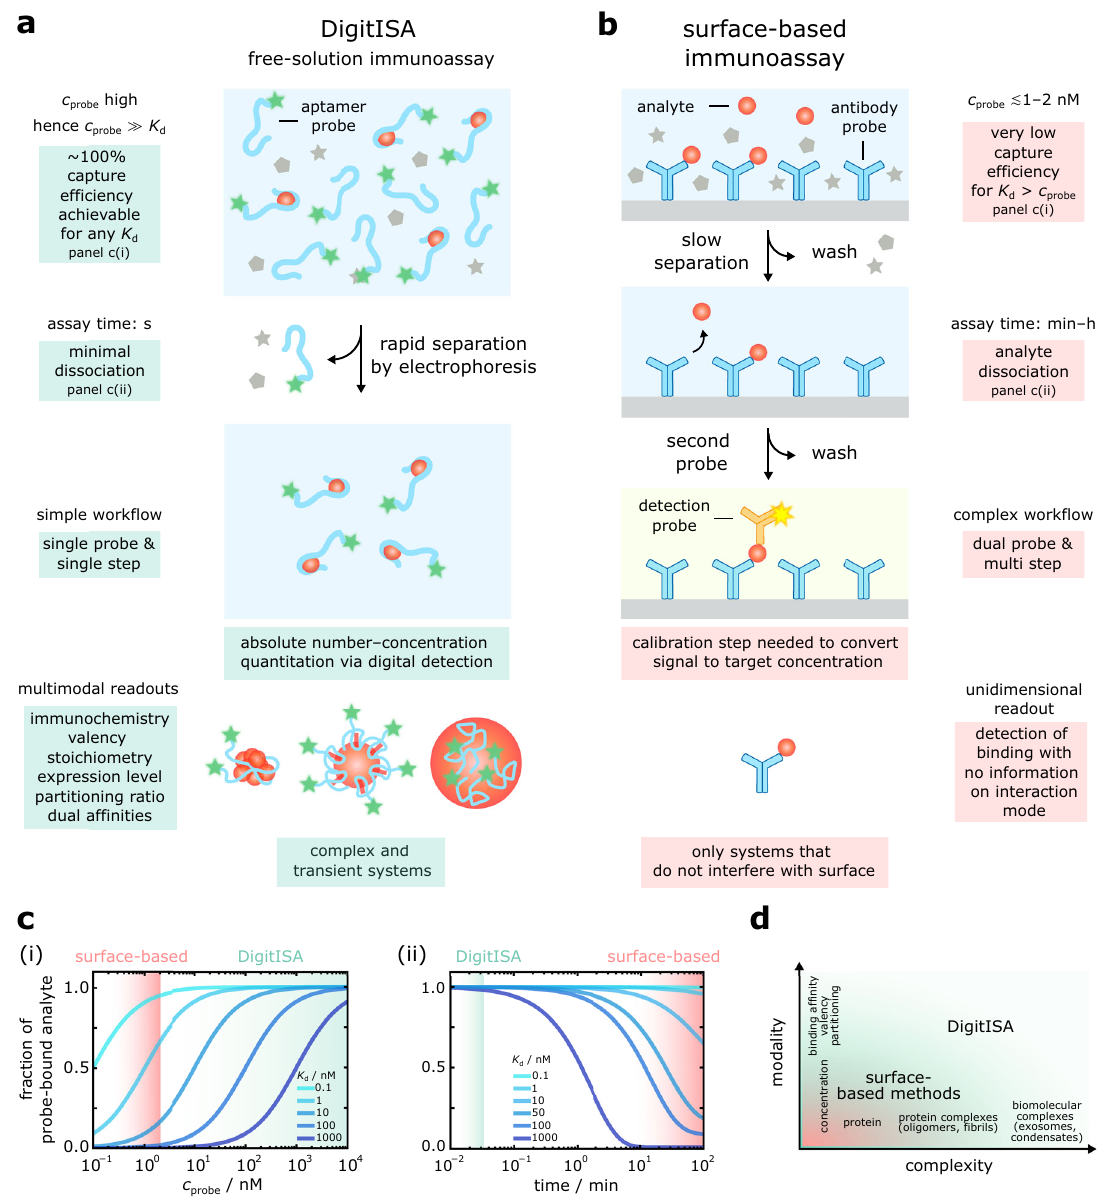
Fig. 8 | Comparison ofthe DigitISA assay withsurface-basedsensing methods. a Schematics depicting the principles of DigitISA and its advantages over surface- based methods. By performing the sensing reaction in solution, high concentra- tions of the af fi nity probe can be used, which permits quantitative target binding, even for probes with dissociation constants K d >1nM (c(i)). Rapid removal of nontarget bound probe by electrophoresis prevents the system from re-